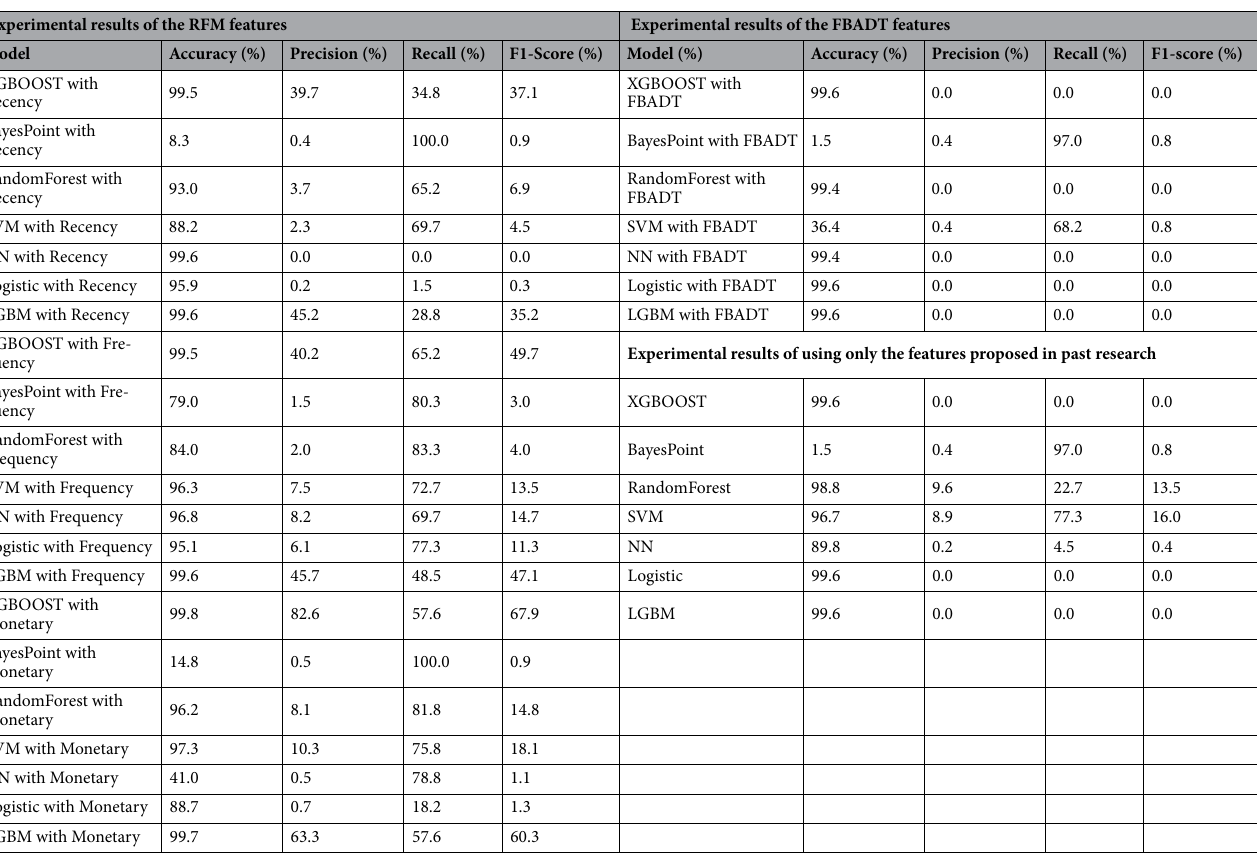
Table 5. Performance of RFM and FBADT features in various